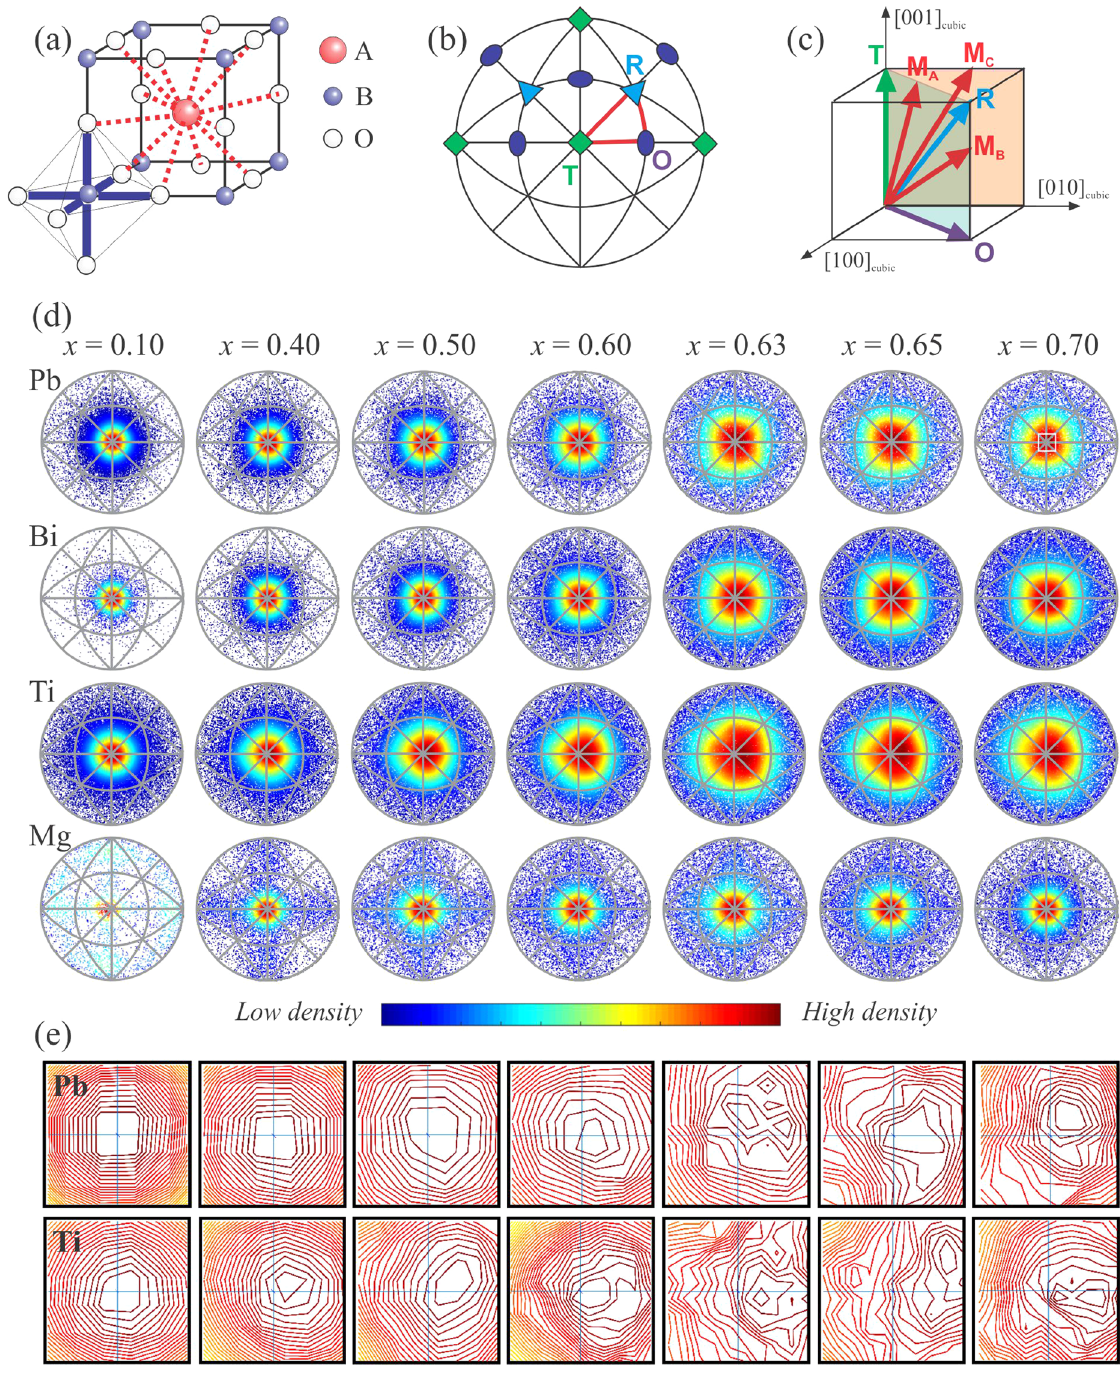
Figure 2. ( a ) Sketch of the aristotype perovskite structure, showing the distinct oxygen environment for the A-site and the B-site cations. ( b ) Typical stereographic projection of a cubic system along the [001] direction. T, R, and O stand for tetragonal, rhombohedral and orthorhombic, respectively, and the symbols in the stereograph represent the preferred directions of cationic displacements in the corresponding polar crystal classes. The red lines mark the crystallographic planes of possible monoclinic polar classes. ( c ) Net polarization- directions in a perovskite-type structure in the case of tetragonal (T), rhombohedral (R), orthothombic (O), and monoclinic (M A , M B , M C ) distortion. M A and M B correspond to Cm with the polarization vector along [ uuv ] pc with u < v and u > v , whereas M C denotes Pm with the polarization vector along [0 uv ] pc 61 . ( d ) [001] pc stereographs for the cation shifts as determined from the refined RMC models. Results from 20 independent runs have been combined to generate good statistics. The colour of each point was assigned following the density distribution around that point. ( e ) Zoomed-in central regions of the stereographs by a factor of 10. For example, the magnified area is marked by a white square in the stereograph of Pb for x = 0.70. The contour lines are obviously the isolines of